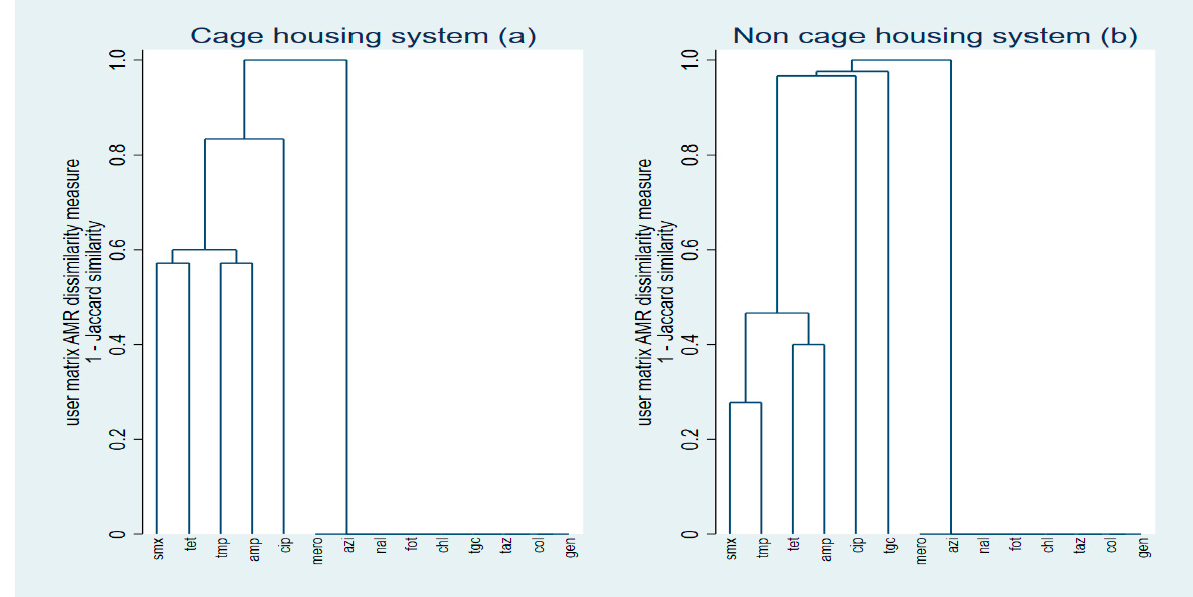
Figure 2. Single-linkage clustering dendrograms of resistance of egg-sourced E. coli ( n = 100) isolates to antimicrobials by production system (( a ) cage and ( b ) non-cage). SMX: sulfamethoxazole; TMP: